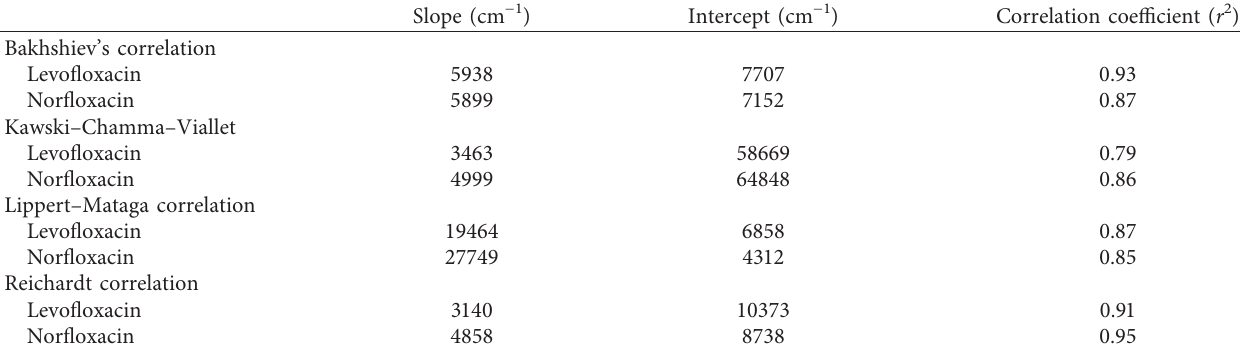
Table 3: Statistical analysis of the correlations of solvent spectral shifts of LVF and